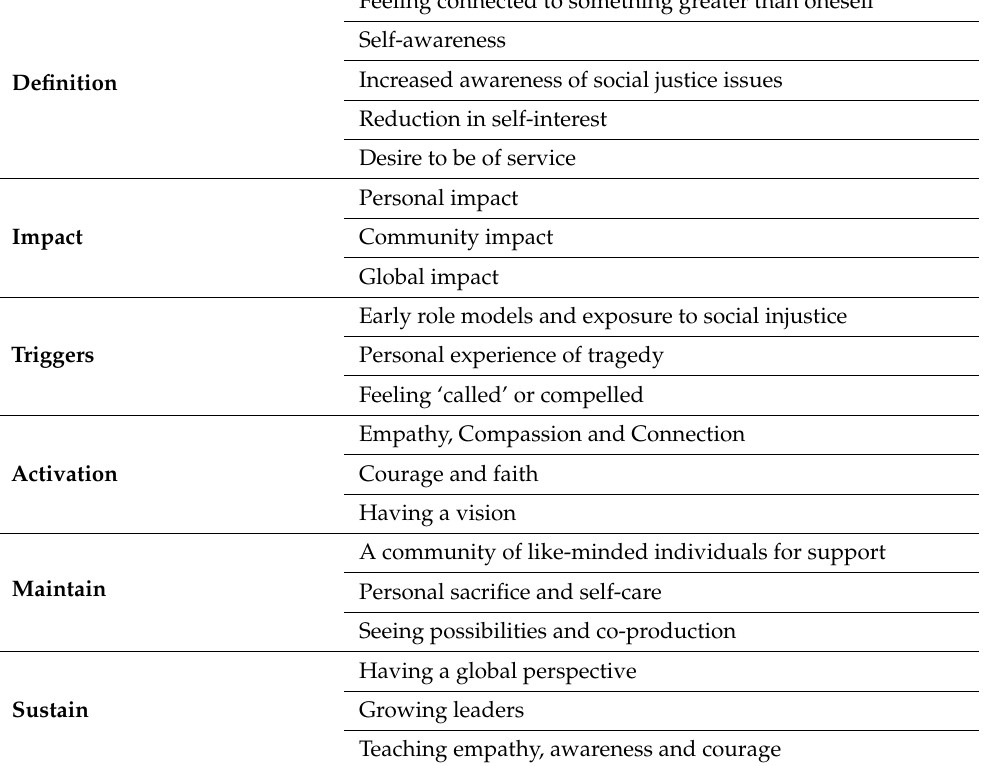
Table 3. Summary of